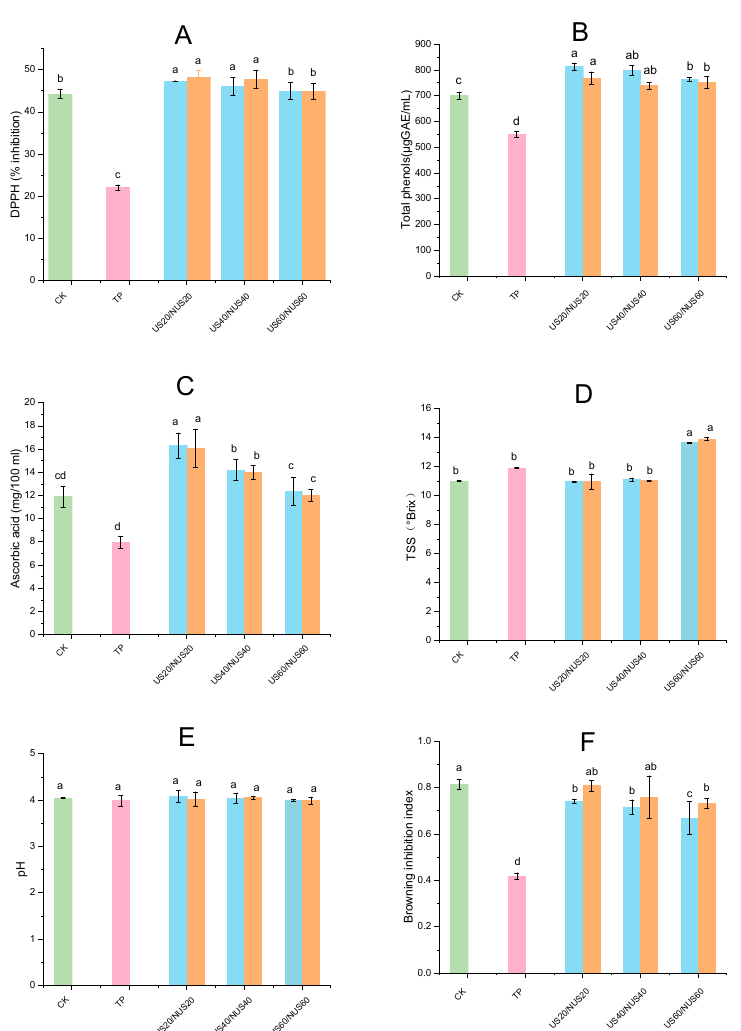
Figure 3. Changes in physicochemical property in chestnut lily beverages treated with different sterilisation techniques. Where ( A ) stands for DPPH inhibition, ( B ) stands for total phenolic content, ( C ) stands for ascorbic acid content, ( D ) stands for pH value, ( E ) stands for TSS content, ( F ) stands for browning Inhibition Index. CK represents the untreated group, TP represents the heat treatment group, US20, 40, 60 represent the ultrasonic treatment groups for 20, 40, 60 min alone; NUS20, 40, 60 represent the ultrasonic combined nisin treatment groups for 20, 40, 60 min. The error bars indicate the standard deviation. Different letters (a, b, c, d) indicate significant differences between the means ( p <